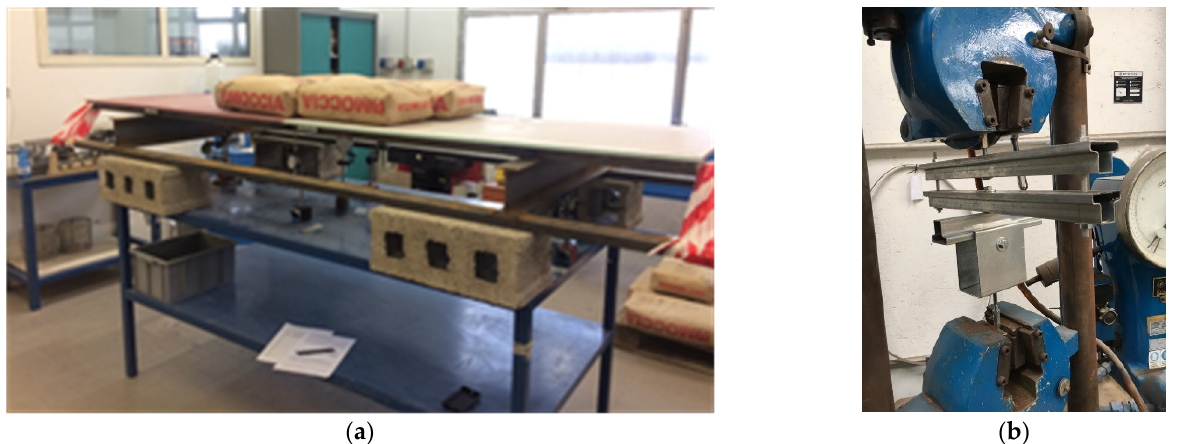
Figure 16. The laboratory testing on the upper and bottom surface of the Corian slabs ( a ). The flexural test in laboratory ( b ).